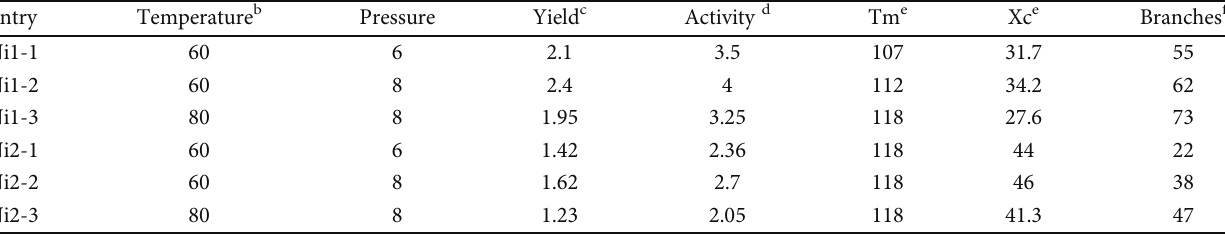
Scheme 2: Chemical structures of Ni1 and Ni2 complexes. Table 1: Ethylene polymerization results a